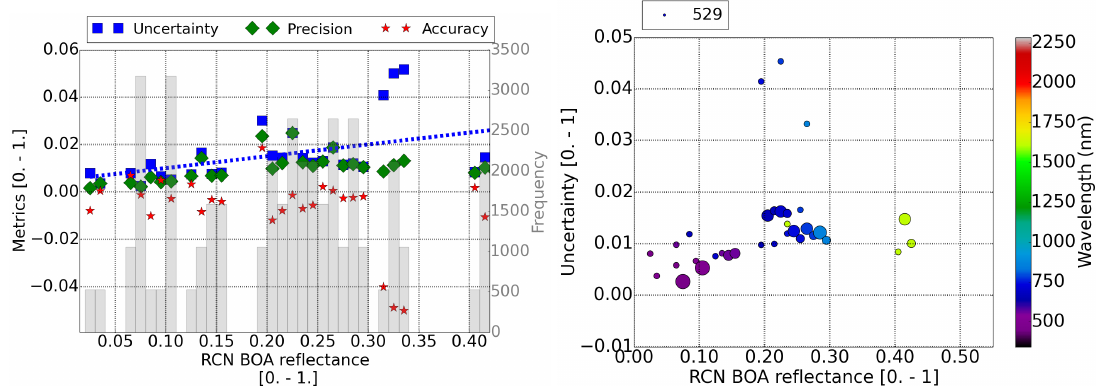
Figure 5. ( Left ) Accuracy (red star), precision (green diamond), and uncertainty (blue square) as a function of the reference value of Sentinel-2 surface reflectance for the La Crau RadCalNet site. The number of pixels included in each bin are shown in the shadow histogram and on the right axis. Uncertainty fit is displayed as a dotted blue line. ( Right ) Uncertainty of the surface reflectance versus the reference value and the band central wavelength. The size of the points scales with the amount of pixels analyzed in each point. The amount of pixels considered for the smaller point is displayed in the legend. In both plots, the swir band (2250 nm), cirrus band (1380 nm), and water absorption bands at 940 nm have been